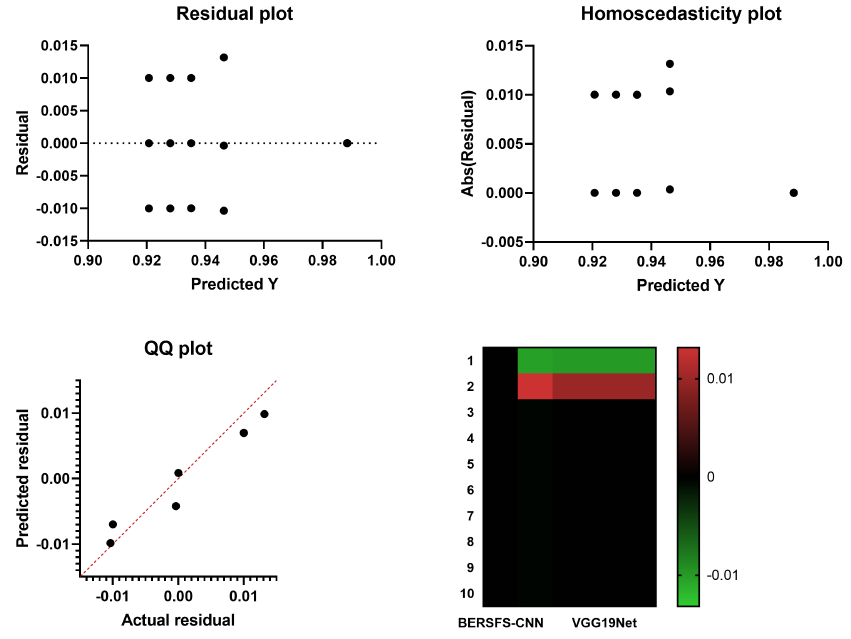
Figure 3. The homoscedasticity graphs, heat maps, residual plots, and QQ plots of the BERSFS-CNN and other deep learning models. Table 8. Results of comparisons between proposed classifiers and those obtained from ANOVA.